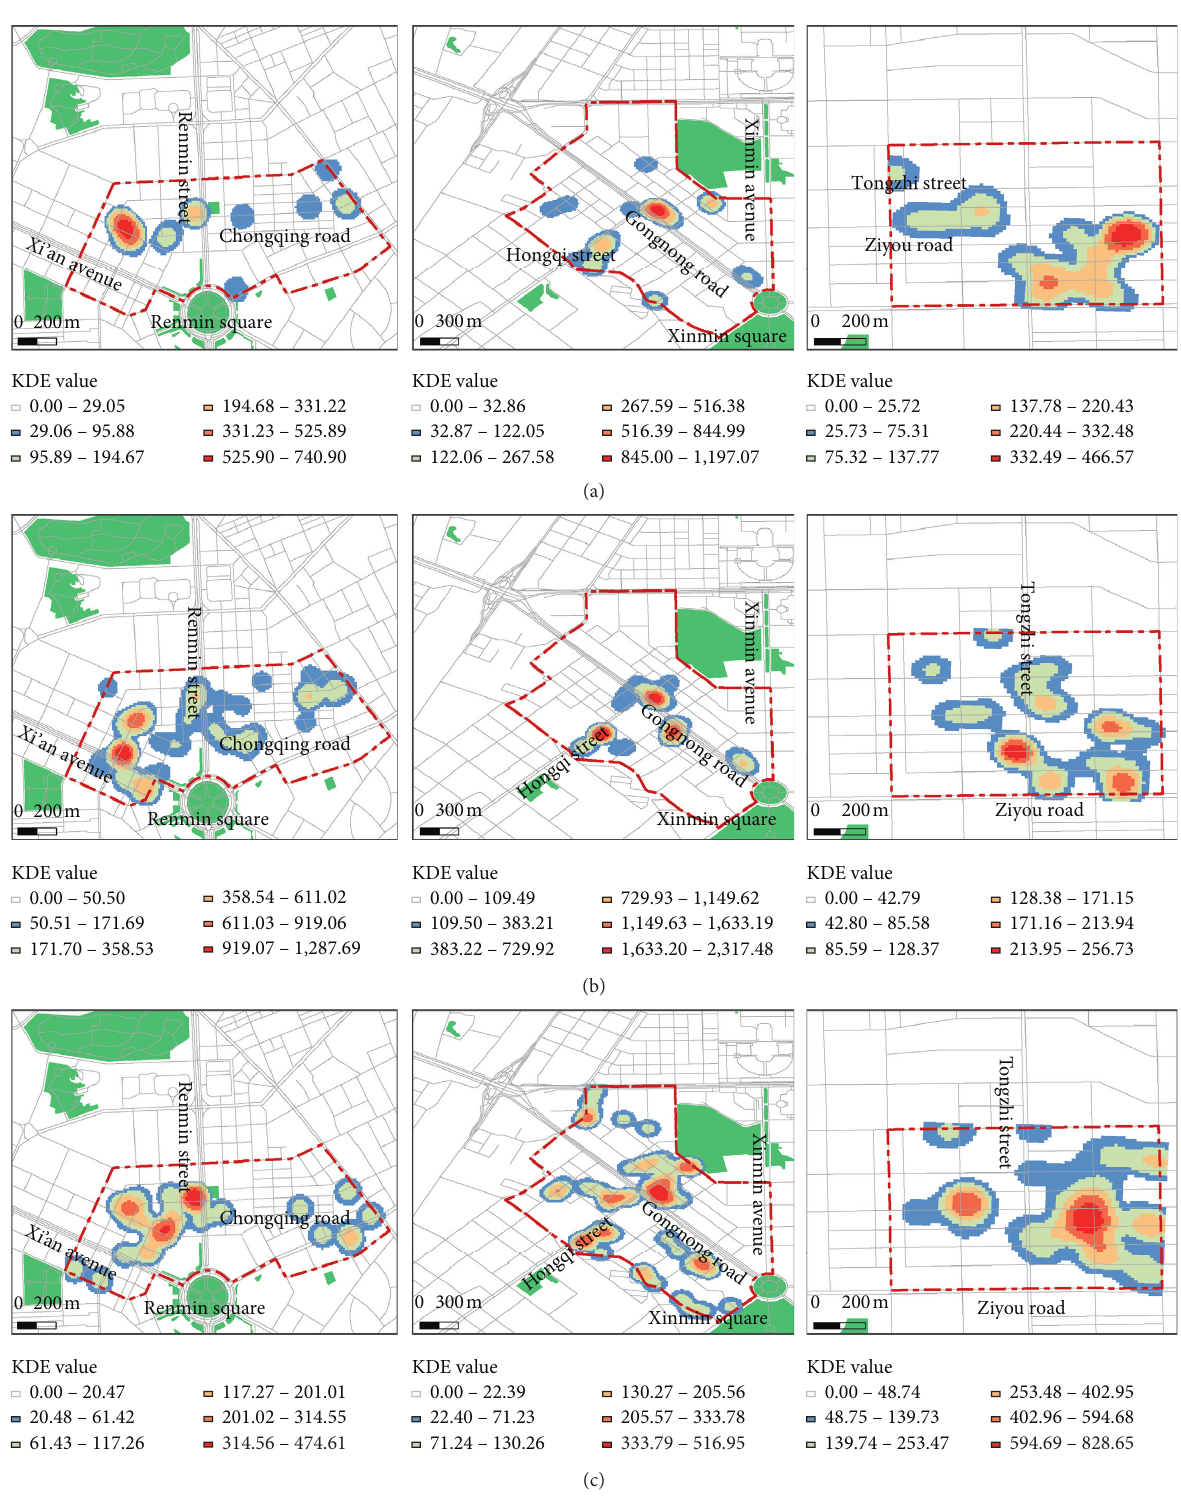
Figure 5: Spatial distribution of (a) HFS, (b) HES, and (c) FBS in the three commercial